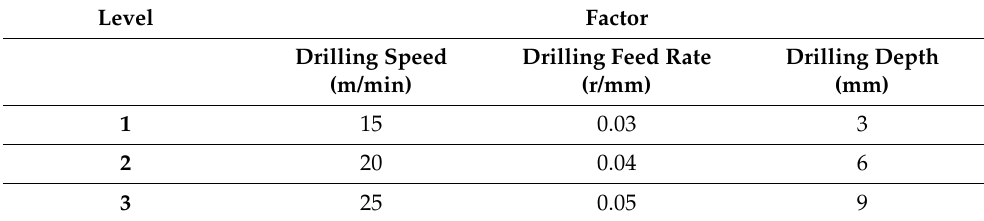
Table 6. Factor level.